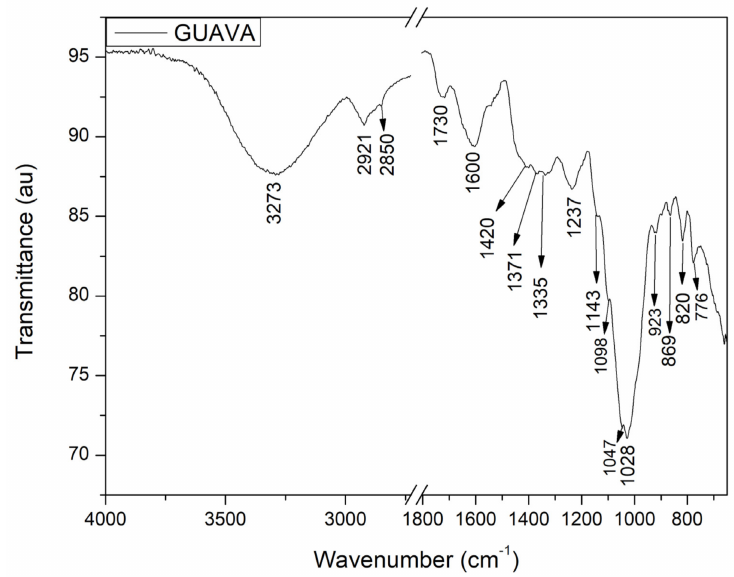
Figure 3. FT-IR spectrum for guava fruit